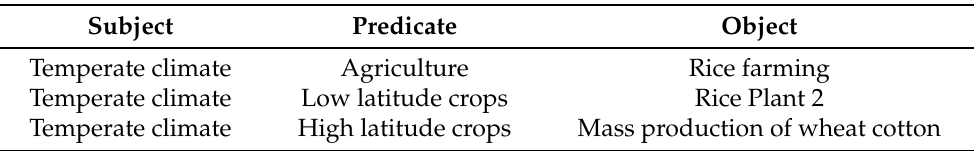
Table 3. (Chapter 3. Temperate Living) triple example that can be configured while conduct- ing